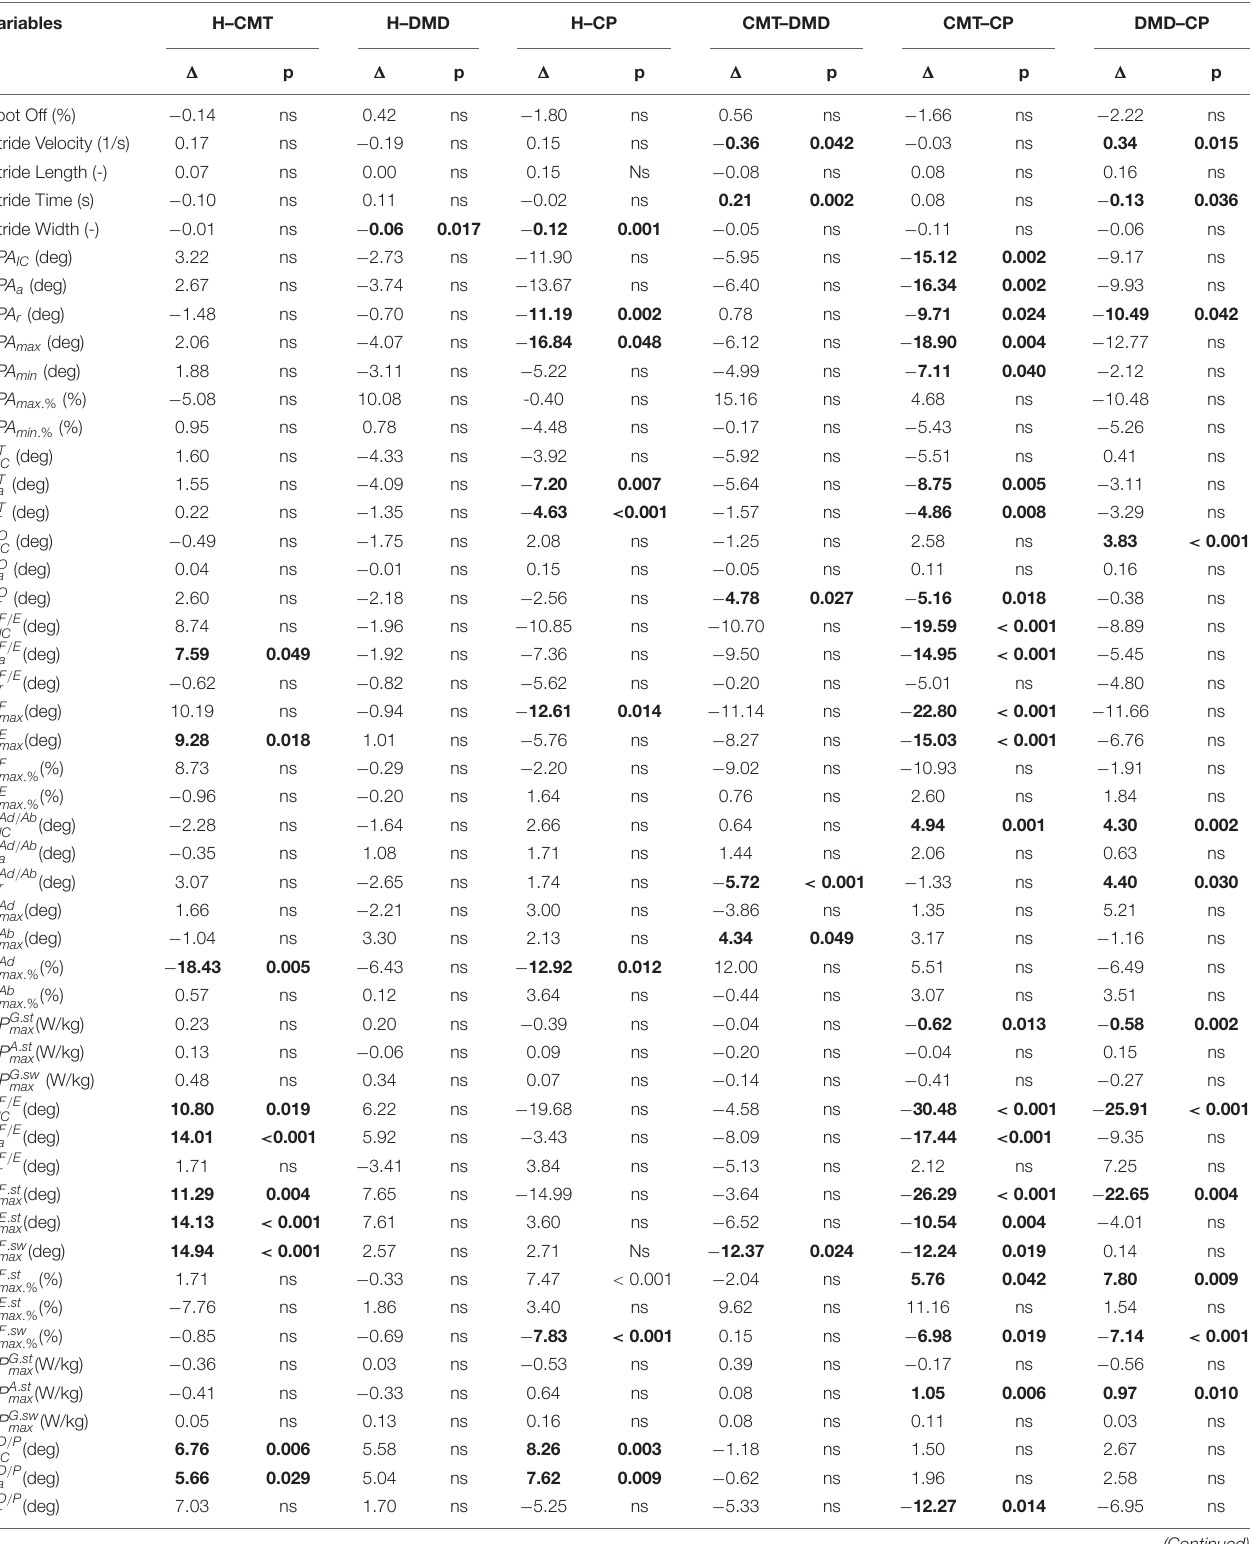
TABLE 3 | Differences between the median values of two different pathologies: Healthy (H), Cerebral Palsy (CP), Charcot Marie Tooth (CMT) and Duchenne Muscular Dystrophy (DMD).